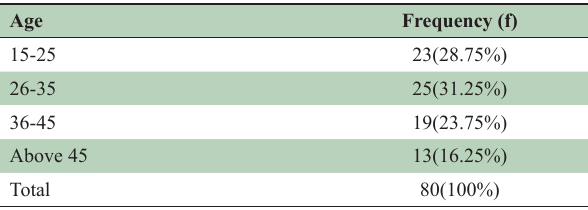
Table-II: Distribution of respondents according to their age.